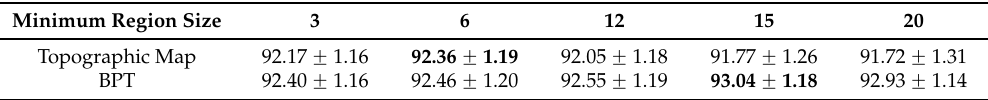
Table 4. Classification results under different minimum region sizes on the UCM dataset.